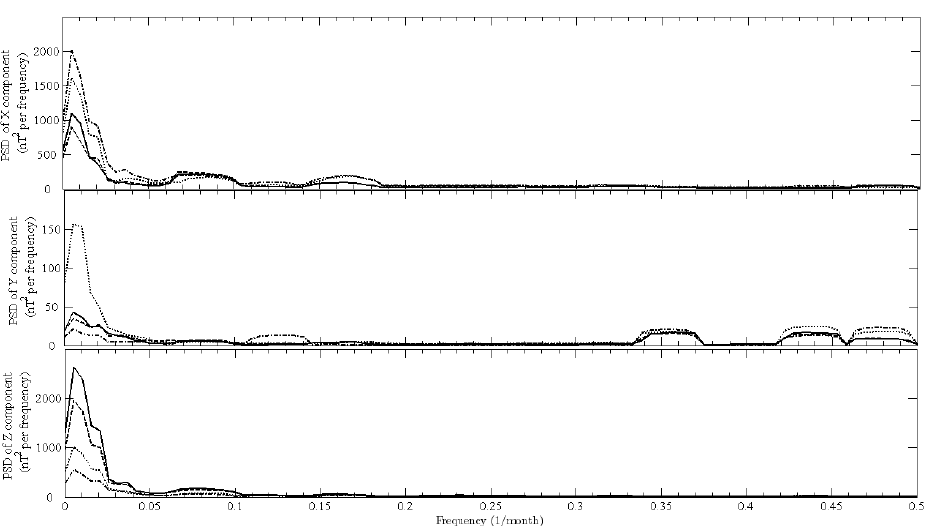
Figure 18. Power spectrum density (PSD in nT 2 /frequency units) calculated by PMTM method for external contributions series of POMME- 9 model at different observatories: NGK (solid line), FUR (dashed line), HER (dotted line), KAK (dash-dotted